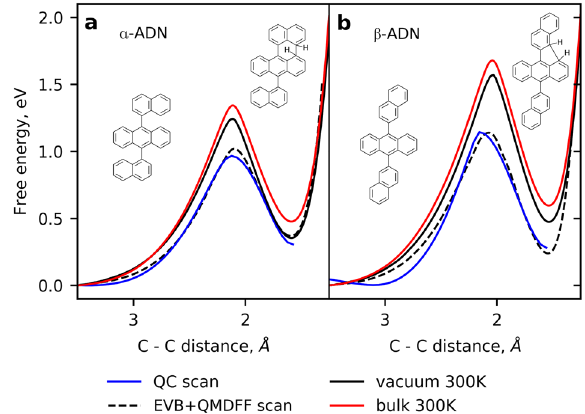
Fig. 3 Energy pro fi les for the crosslinking reaction in ADN. C – C bond distance was used as a reaction coordinate both for α -ADN ( a ) and β -ADN ( b ) molecules. Solid blue and dashed black lines show the results of relaxed potential energy scans, performed with the DFT and EVB + QMDFF approach, respectively. Solid black and red lines show results of EVB + QMDFF calculations in vacuum at 300 K and in the bulk of ADN molecules at 300 K,